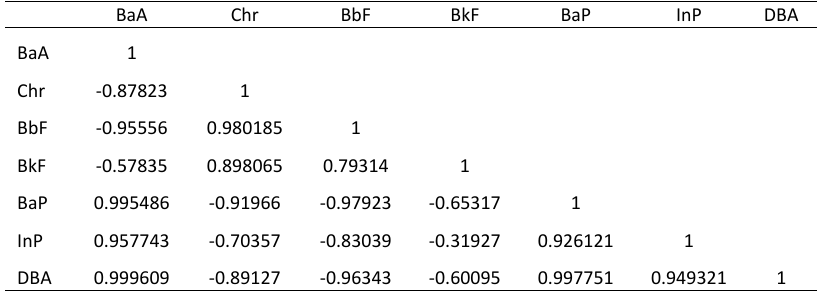
Table 2: Pearson correlation coefficient of carcinogenic PAHs